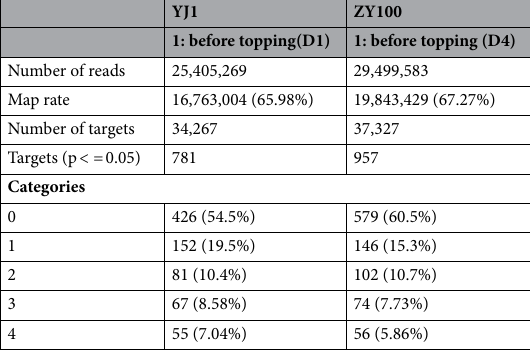
Table 2. Summary data of degradome sequencing from ZY100 and YJ1.